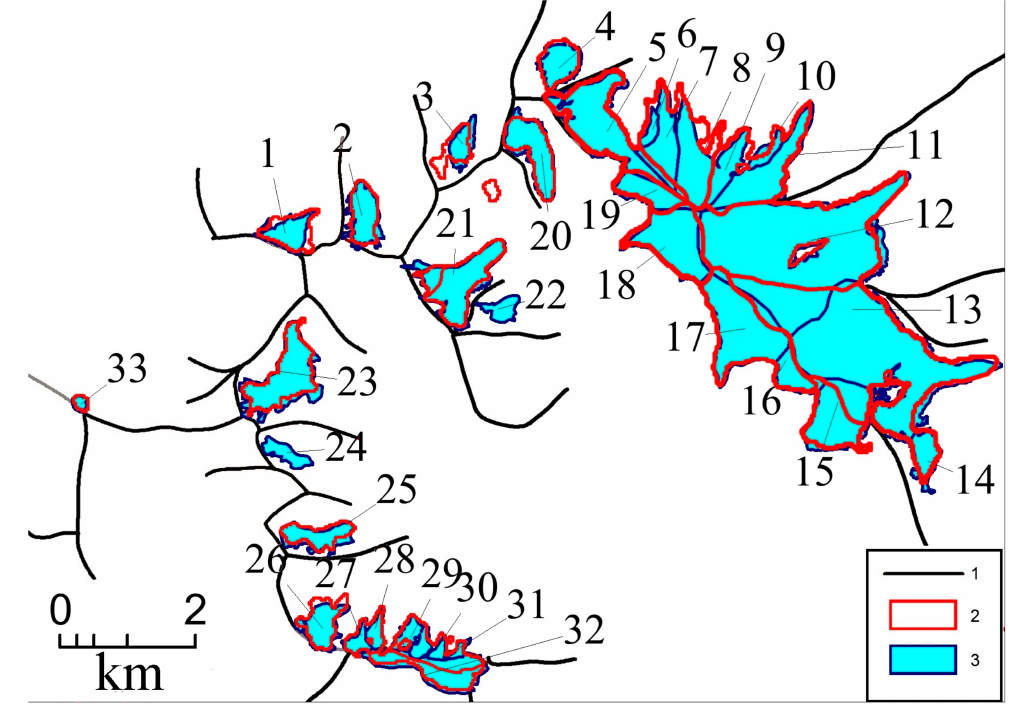
Figure 17. Present glaciers of the Mongun-Taiga massif according to our data (2016) and to the RGI 5.0/GLIMS database [41,42] 1 : Mountain ridges and watersheds; 2 : RGI 5.0/GLIMS contours of the glaciers; 3 : glaciers according to our